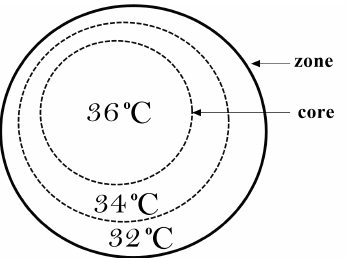
Figure 2. Core is inside of the zone, which represents an extent of a set of the spatial contiguous of the statistical temperatures. study proposed a core region to describe complex landform of canyons, which is one of the most representative characteristics for canyons (Guilbert and Moulin 2017). With the similar ap- proach, a zone can have a representative core region where abso- lute temperatures within the core region are equal or higher than the representative temperature . As drawn in Figure 2, a core is an enclosed region in the zone that temperatures within the re- gion equal to the representative temperature (i.e. the maximum temperature) of 36 degrees Celsius. For the ease of representa- tion, a new concept of core is introduced so that the core-oriented behavior modeling can be